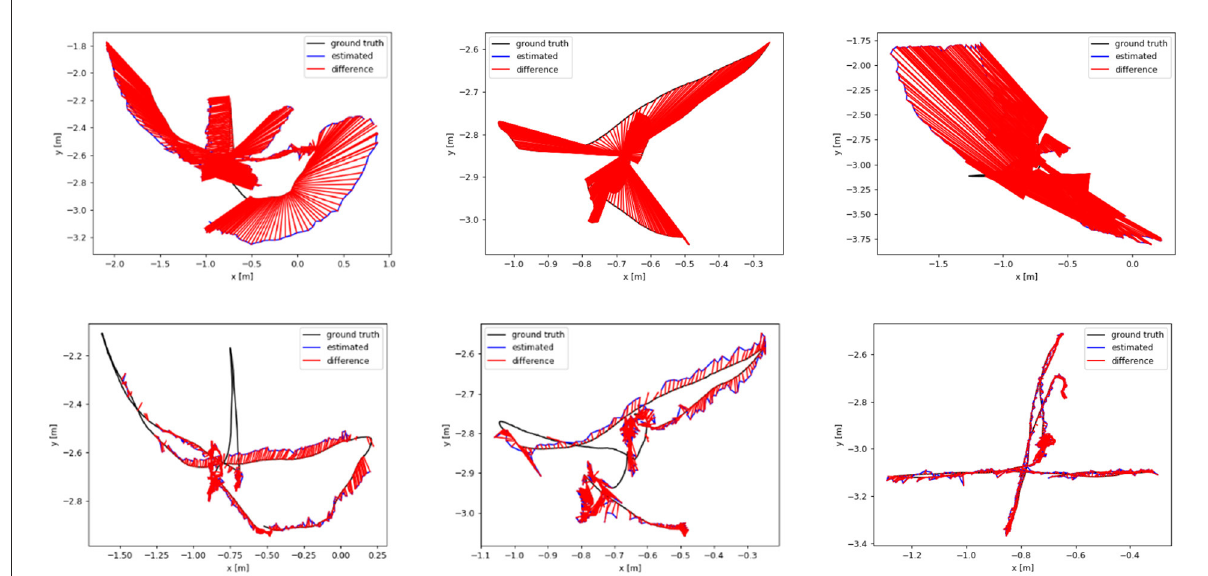
FIGURE13 The (top) row is the trajectory error graph of ORB-SLAM2, and the (bottom) row is the trajectory error graph of ours. The ground truth, the estimated camera motion, and the localization error for each camera pose are represented as the black, blue, and red segments, respectively.